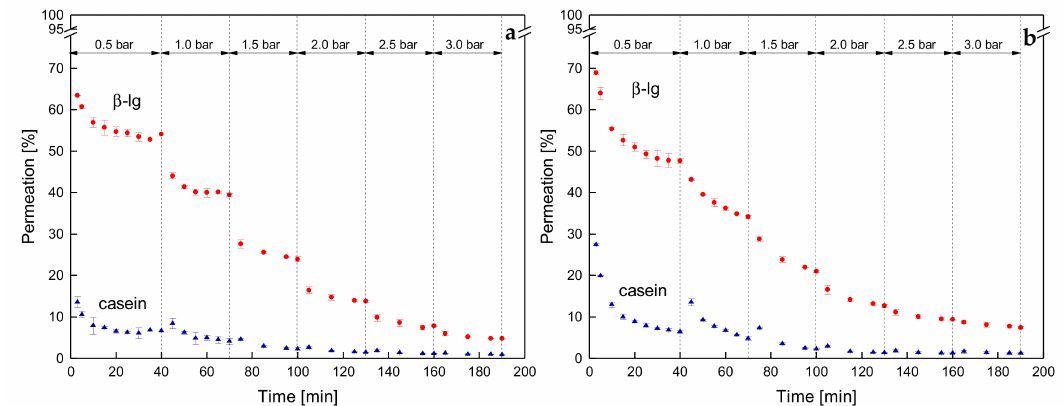
Figure 8. Protein permeation of β -lg (circles) and casein (triangles) as a function of time for stepwise increasing ∆ p TM at 10 ◦ C ( a ) and 50 ◦ C ( b ).